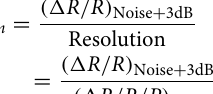
Figure 5. ( A ) The piezoresistivity of the noise and 3 dB higher than the noise level. The dashed line represents the calculated piezoresistivity at 1 mPa pressure ( B ) Minimum detectable pressure ( P mim ) calculated from the is represented by the green line, and the blue line represents the noise level. The dashed line represents the piezoresistivity calculated from result shown in Fig. 4F, when 1-mPa pressure is applied. As shown in Fig. 5A, the resistive change of the proposed sensor at 1 mPa is much higher to the minimum required value. Figure 5B shows the mimum detectable pressure ( P mim ) calculated as: